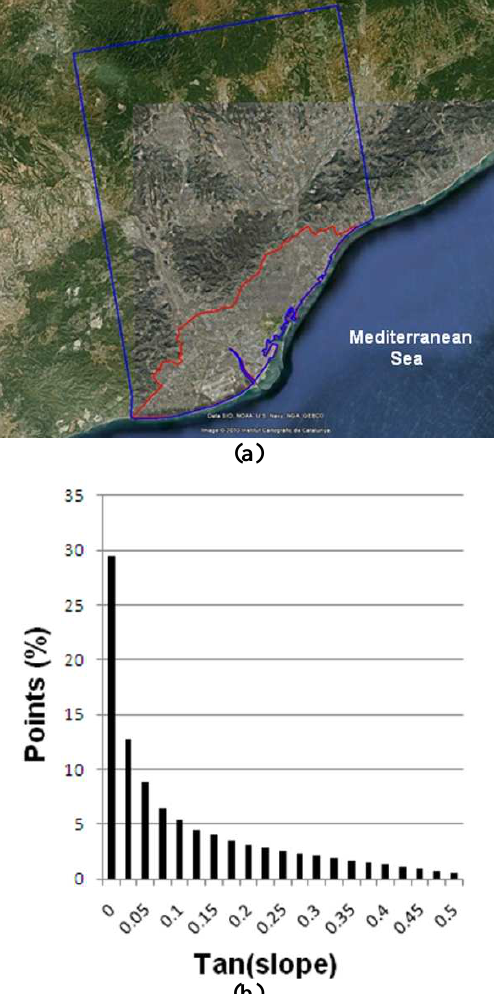
Figure 1. Barcelona test site (a) and frequency distribution of terrain inclination (b)